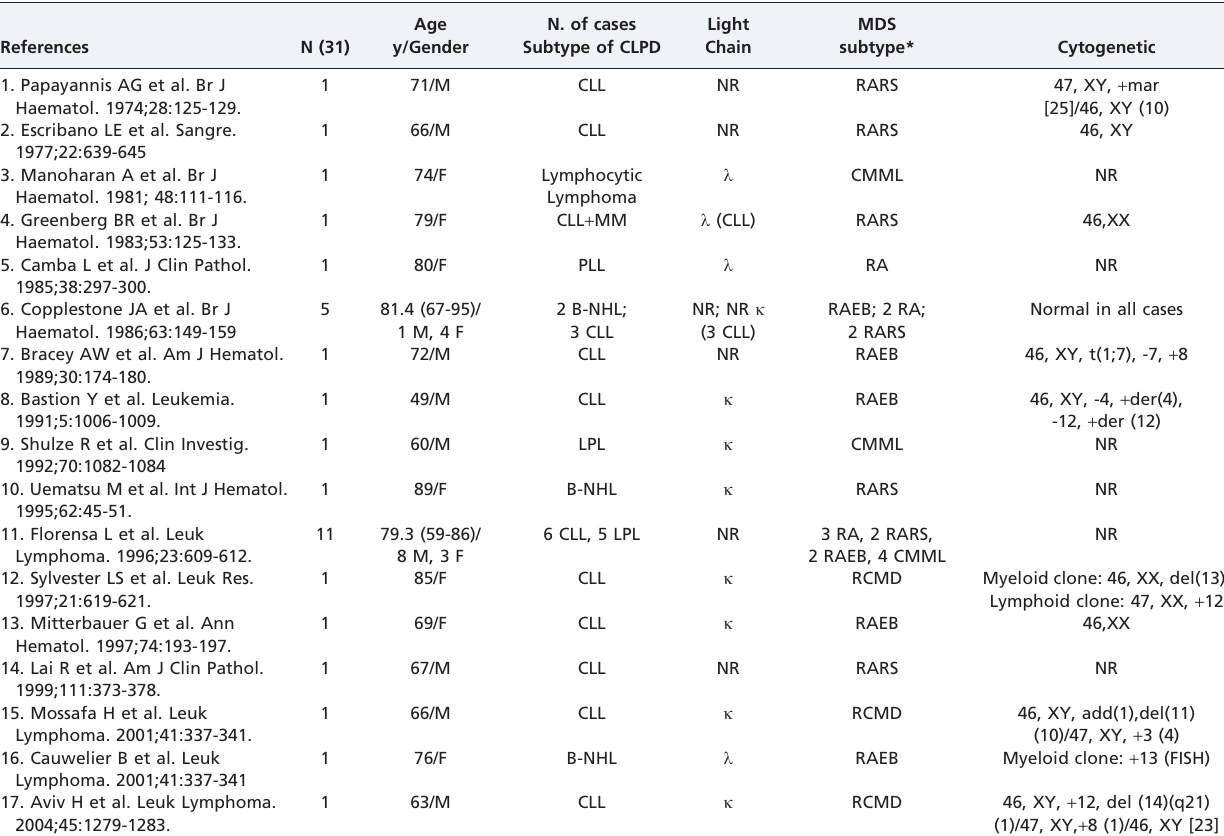
Table 2 - Previous reports of MDS and B-chronic lymphoproliferative disorders